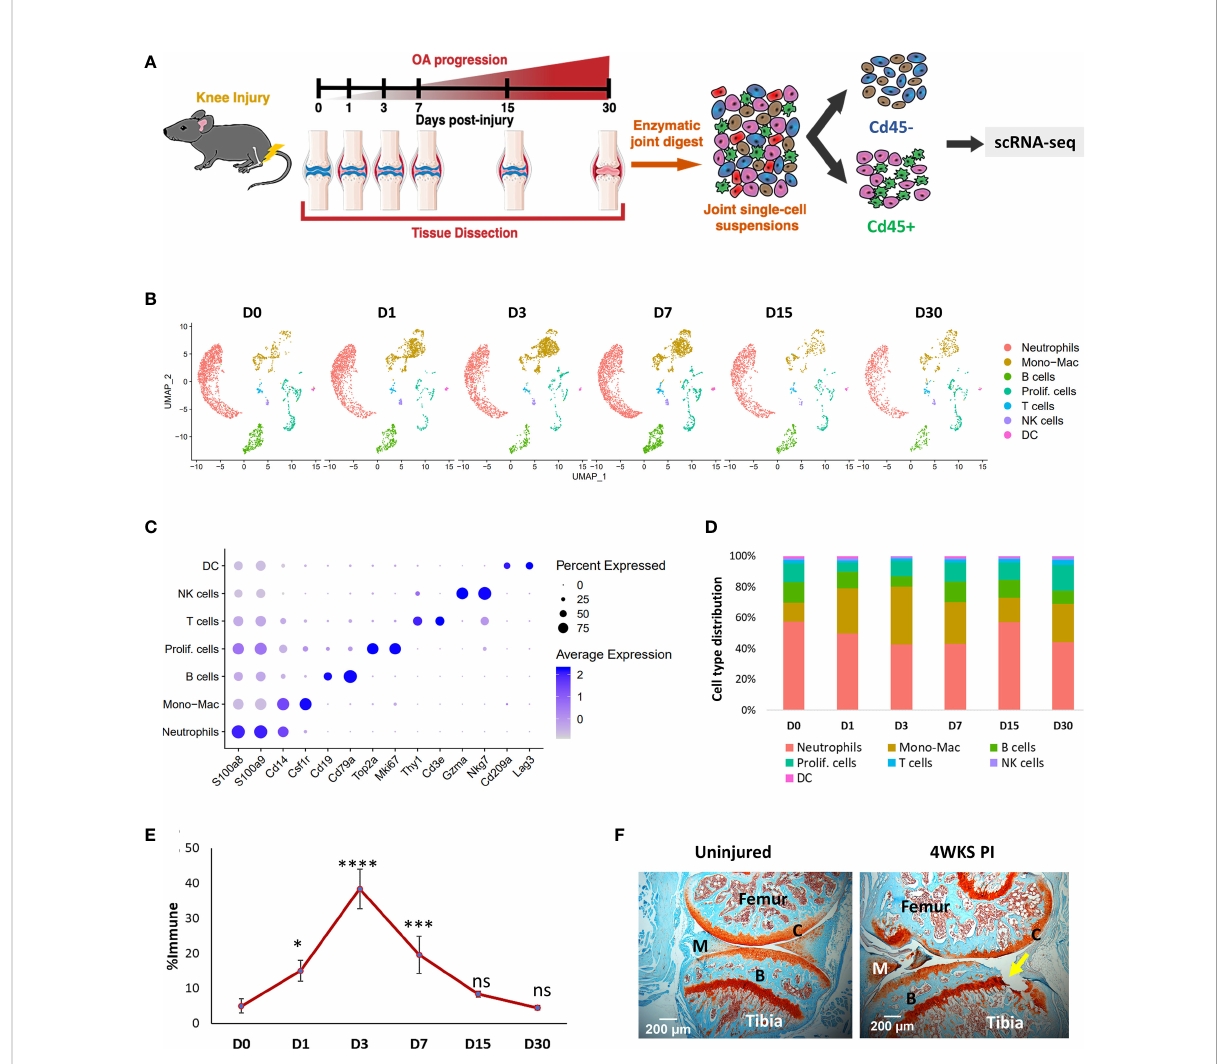
FIGURE 1 Single-cell analysis of injury-induced immune changes in 10-week-old BL6 mouse knee joints. (A) Graphical representation of the experimental work fl ow. Uninjured (D0) and injured (D1, D3, D7, D15 and D30) knee joints were dissected, dissociated into single cells and immune and non- immune fractions were sequenced separately using scRNA-seq. (B) Cell clusters from scRNA-seq analysis visualized by Uniform Manifold Approximation and Projection (UMAP). Colors indicate clusters of various cell types. (C) Dot plot showing the expression of selected markers of various cell types. Dot size represents the fraction of cells expressing a speci fi c marker while the intensity of color indicates the average expression level for each gene. (D) Changes in the proportion of various immune cell types in the joint over time. scRNA-seq analysis showed a dramatic increase in Mono-Macs after injury, which peaked at D3. (E) Flow cytometry analysis of injury-induced changes in monocytes/ macrophage population. Compared to D0, there was a signi fi cant increase in CD45 + CD11b + Ly6C + Ly6G - monocytes/macrophages in the knee joints after injury. Data is represented as mean ± standard deviation (SD). *p<0.01; ***p<0.0001; ****p<0.000001; ns, not signi fi cant (one-way ANOVA and Tukey ’ s post hoc test). (F) Safranin-O histological stained sections of uninjured and 4-weeks post-injury joints (4WKS PI). Arrow indicates cartilage damage observed at 4WKS PI. C, cartilage; B, bone; M, meniscus. 5× magni fi cation; scale bars = 200 m